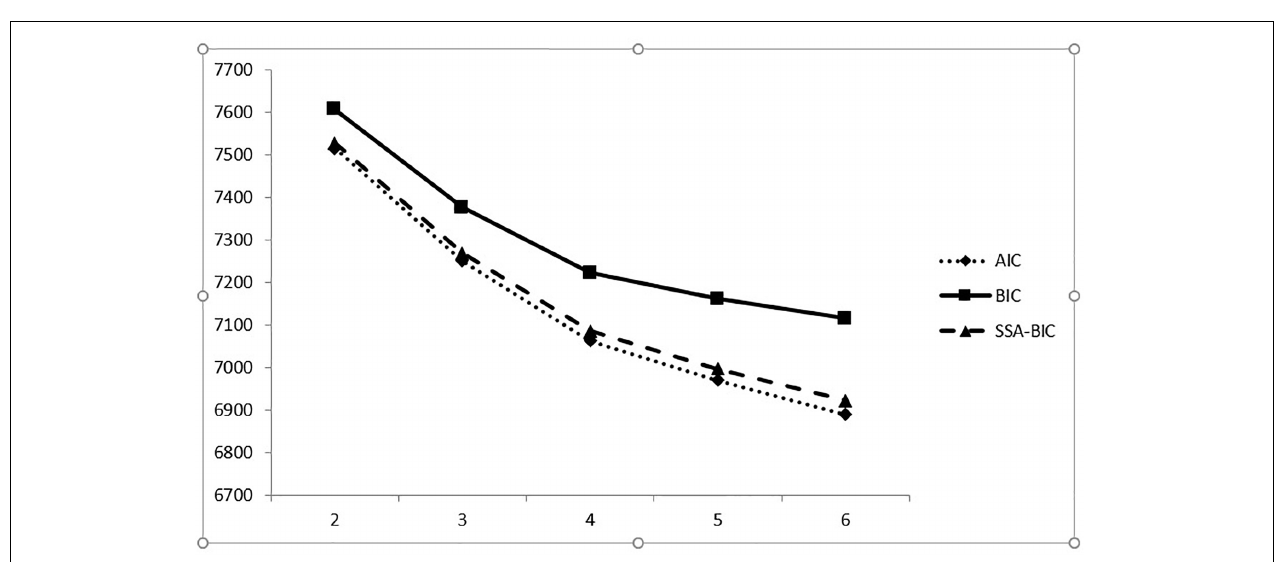
FIGURE 3 | Hypothesis model testing: the structural equation modeling results (Study 2). Note that Emotional Attachment and Striving Behavior are the dimensions of the Chinese Organizational Identification Questionnaire.